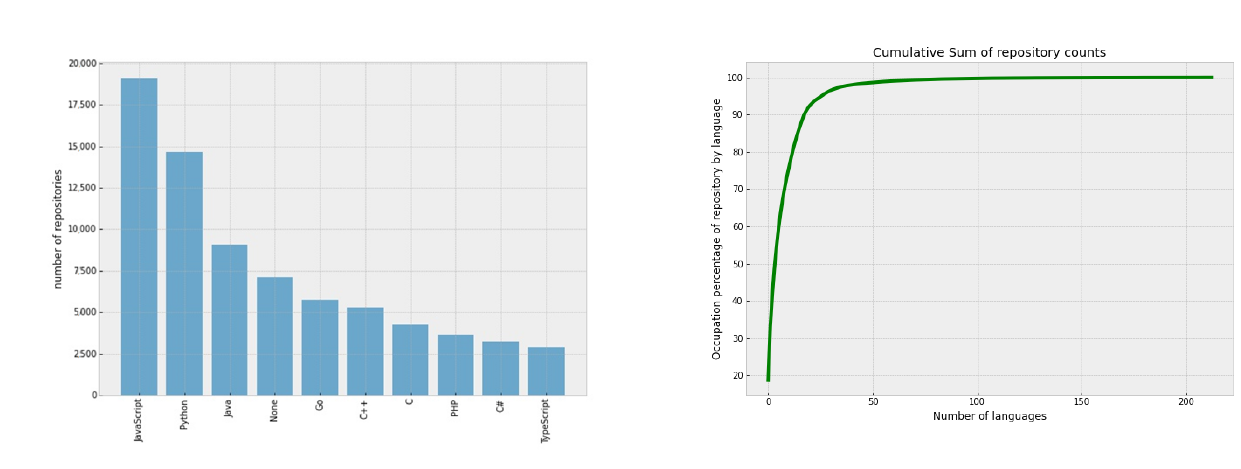
Figure 6. Statistics of the number of repositories per